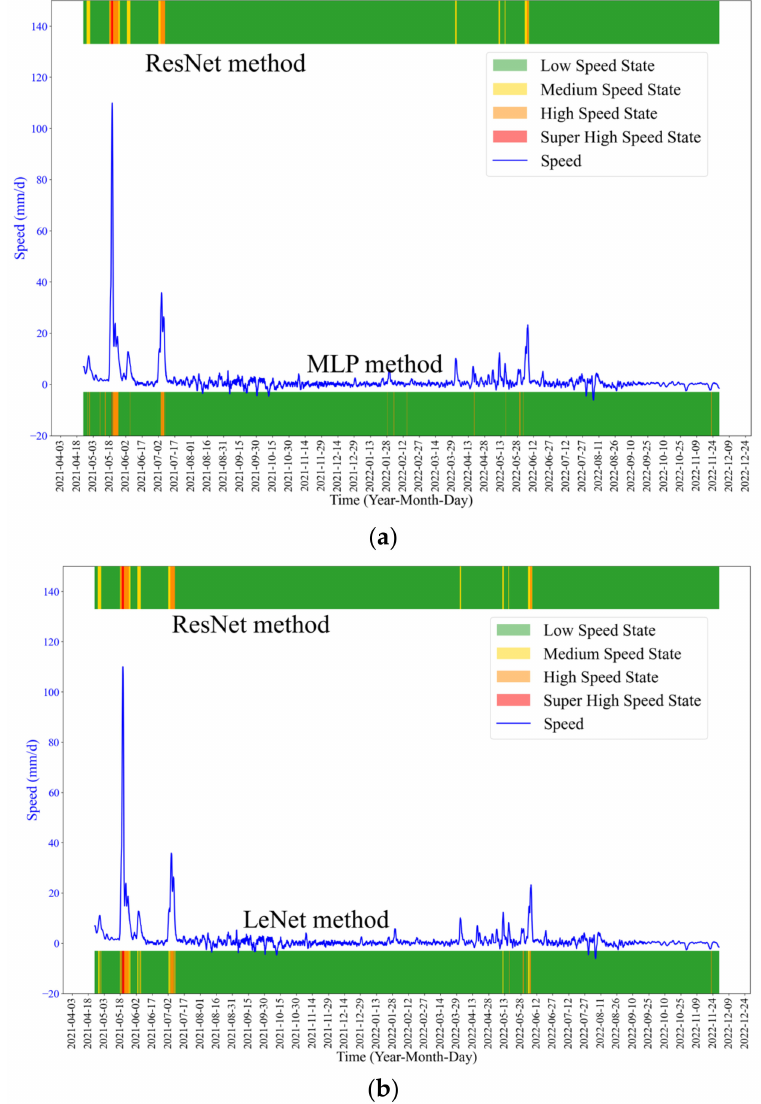
Figure 18. Results of warning ( a ) MLP methods and ( b ) LeNet methods.